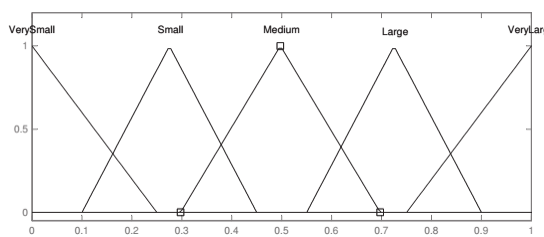
Fig. 1. Membership functions for MRR, TWR and R a